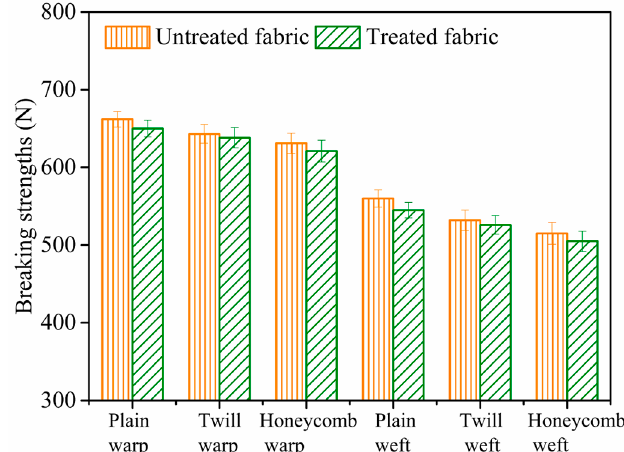
Figure 12. Tensile breaking strength of untreated and treated cotton fabrics.